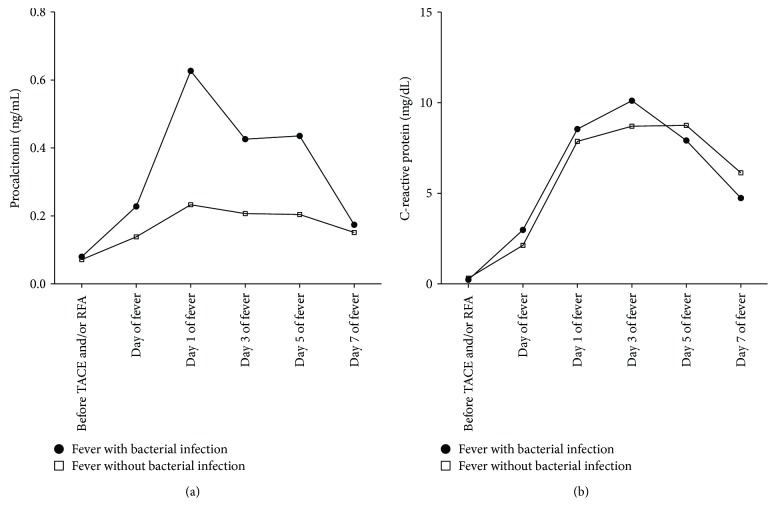
Median procalcitonin (a) and C-reactive protein (b) values over 7 days after onset of fever according to the etiology of fever. Basal, afebrile status before TACE or RFA.